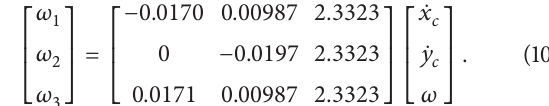
From Table 1 and specification that 𝑟 = 50.67 mm and 𝑙 =